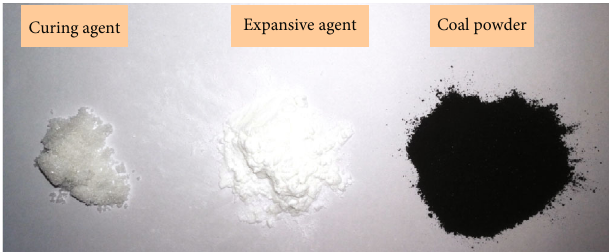
Figure 5: Raw materials of grouting.